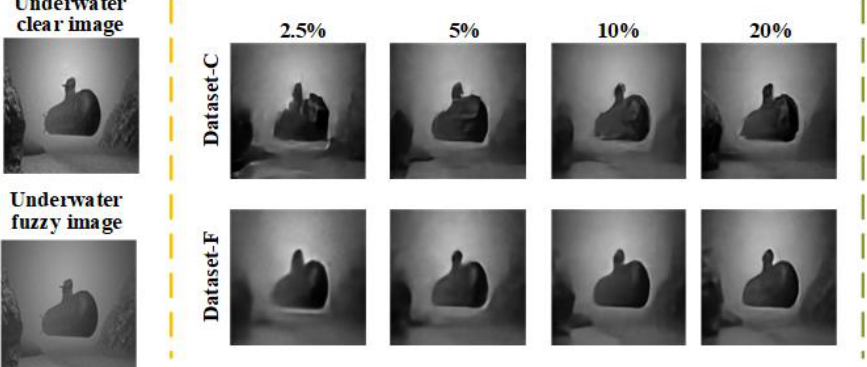
Figure 8. Comparison of simulation results of UGI-GAN trained with dataset-F and dataset-C at different sampling rates.